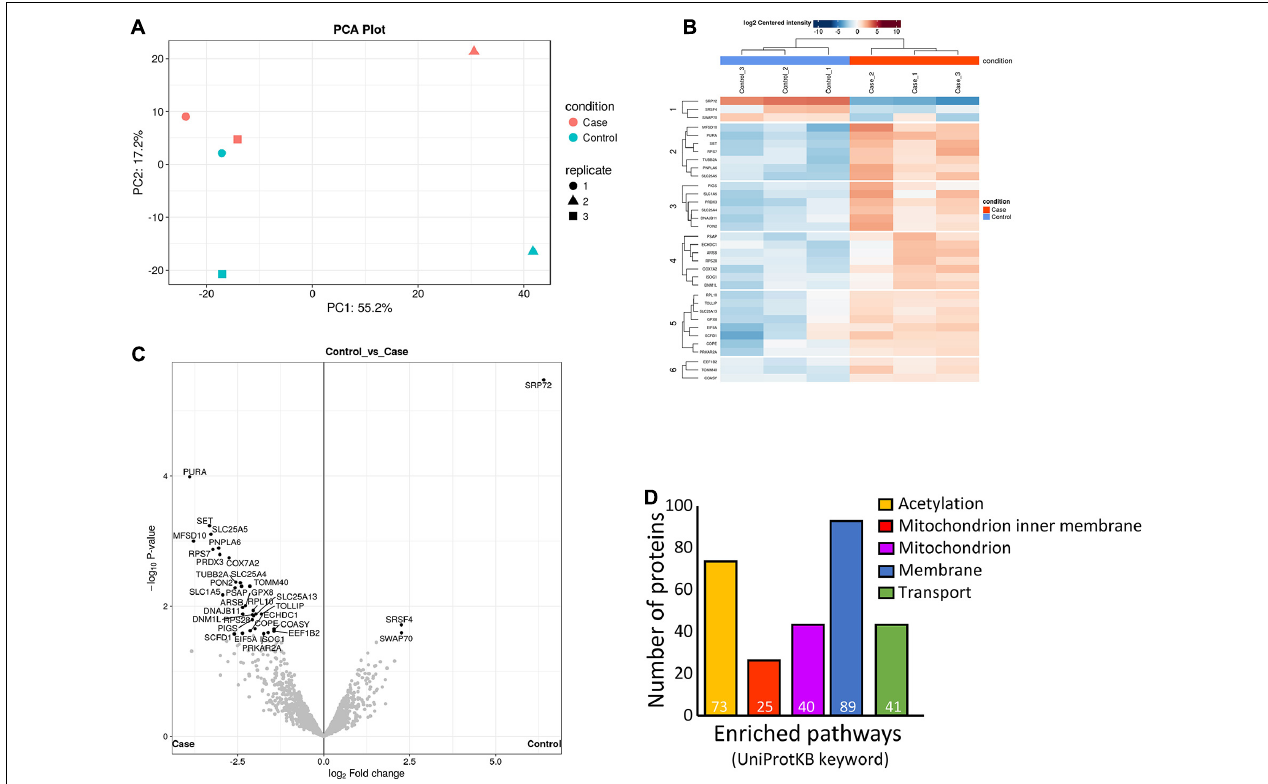
FIGURE 3 | Analysis of differently regulated decidualized human endometrial stromal fibroblast (hESF) proteins following in vitro decidualization in the presence of prednisolone. (A) Principal components analysis. (B) Heat-map. (C) Volcano plot. (D) Enriched pathways. Individual numbers of proteins identified is indicated in white at the base of each bar. Case: prednisolone treated hESF; Control: vehicle control treated